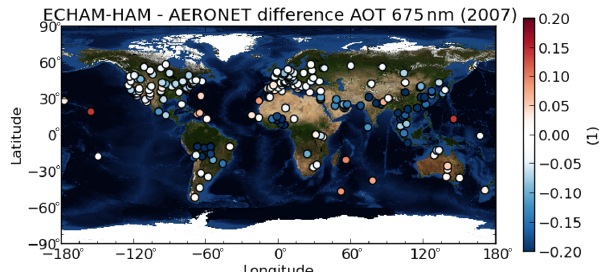
Figure 12. The difference between the annual average AOT mea- sured at AERONET stations around the world and ECHAM6- HAM2 modelled values. This plot only demonstrates a type of anal- ysis which is easy to perform with CIS; no scientific critique of these differences is